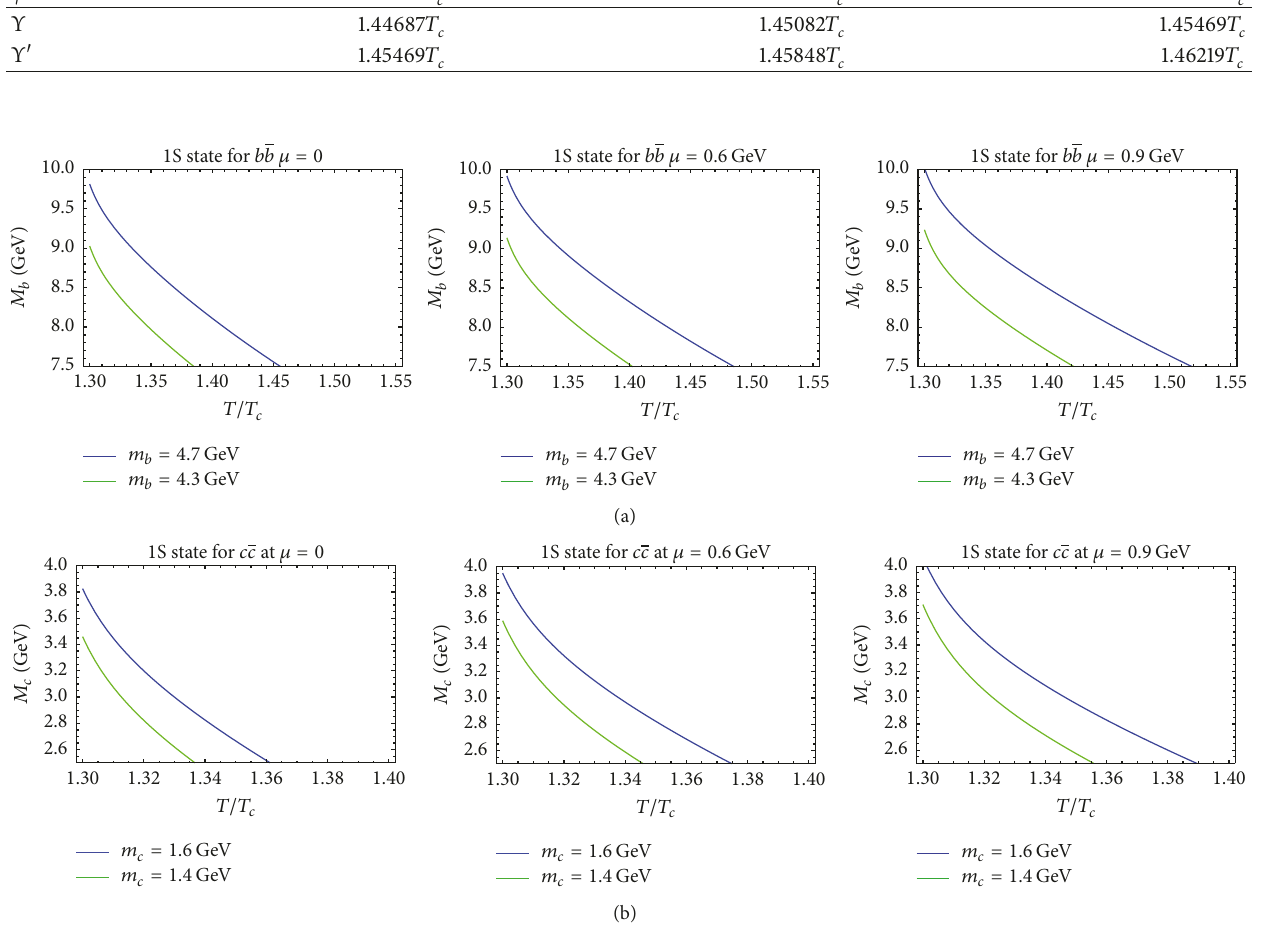
Figure 9: The mass spectra of heavy quarkonia are plotted as a function of temperature for 1S state, bottomonium in (a) and charmonium in